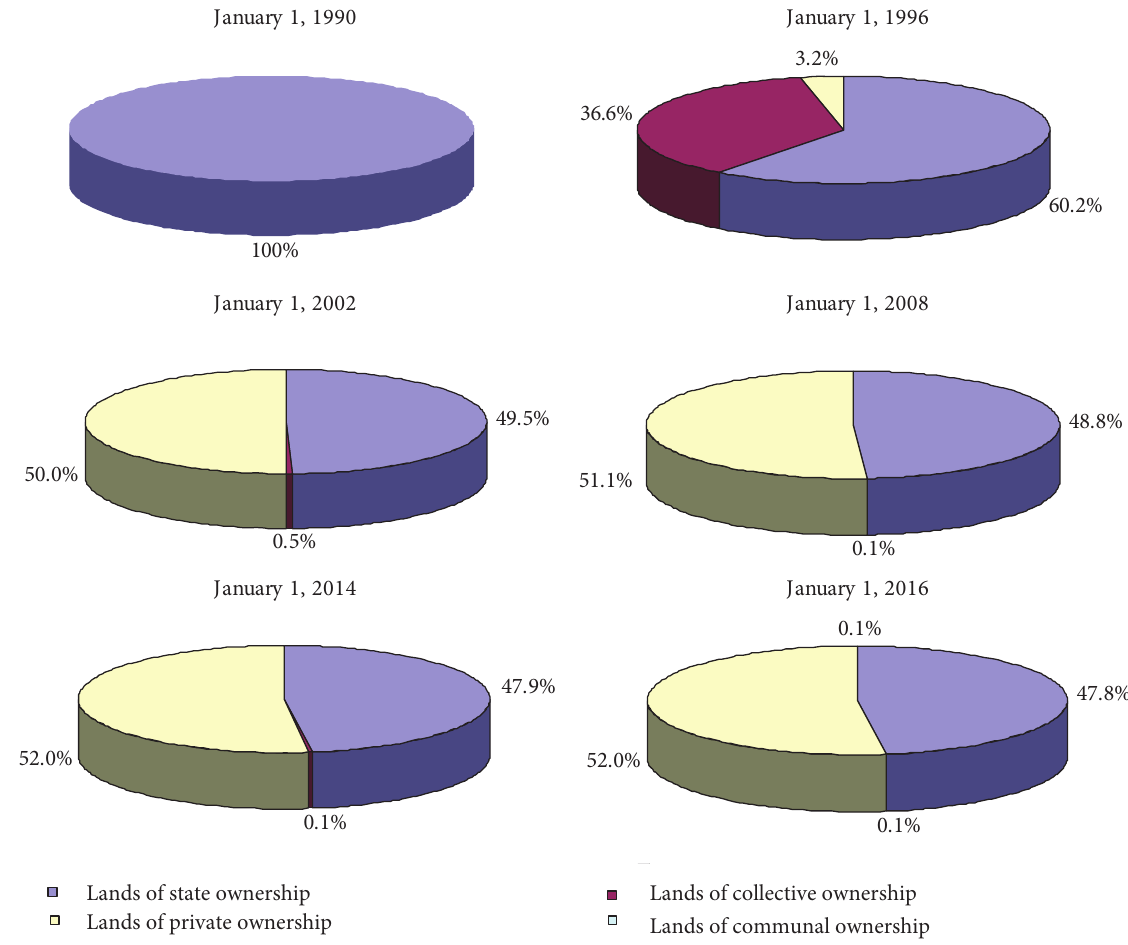
Figure 1. The land fund of Ukraine by forms of ownership in accordance with the data of the StateGeocadastre, % of the total